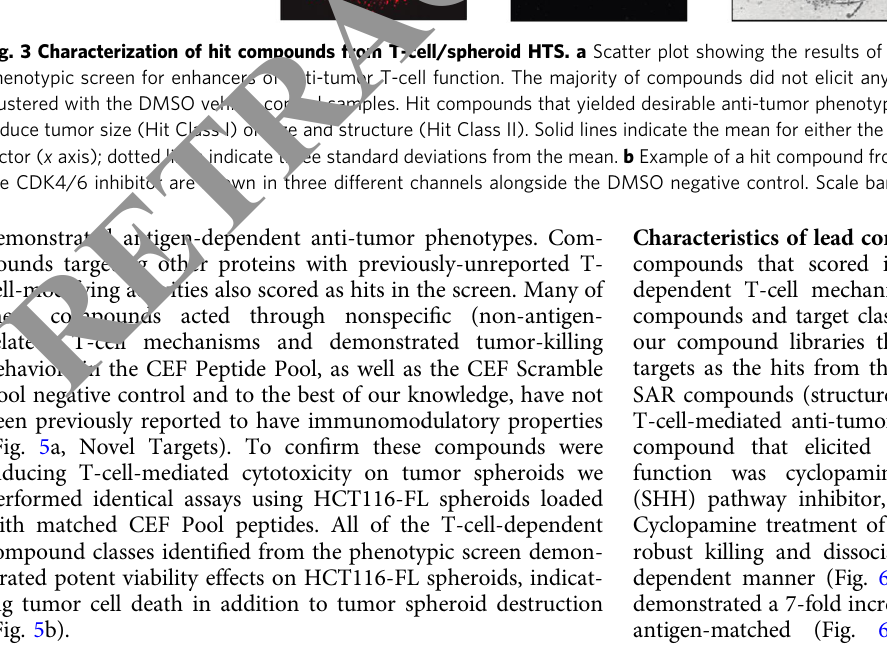
performed identical assays using HCT116-FL spheroids loaded with matched CEF Pool peptides. All of the T-cell-dependent compound classes identi fi ed from the phenotypic screen demon- strated potent viability effects on HCT116-FL spheroids, indicat- ing tumor cell death in addition to tumor spheroid destruction (Fig. 5b).